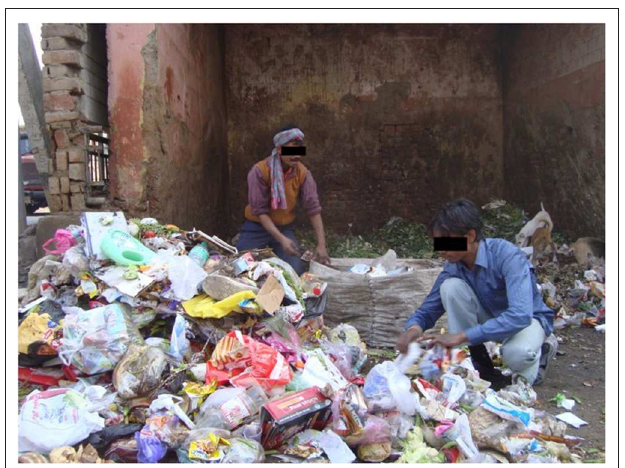
FIGURE 7 | The recycled waste is collected and stored at the waste pickers’ jhuggies where it is further segregated into 54 different types of recyclable.